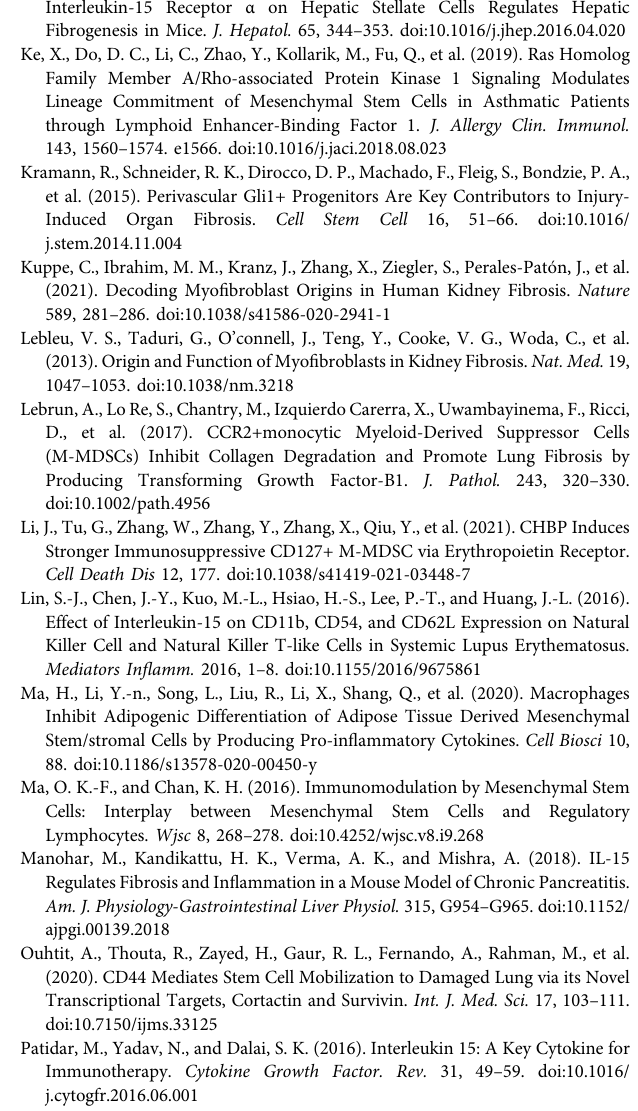
redOstainingandAlizarinRedstainingofRRMSCsaftertheinductionofadipogenic and osteogenic differentiation. Supplementary Table S1 | List of primers